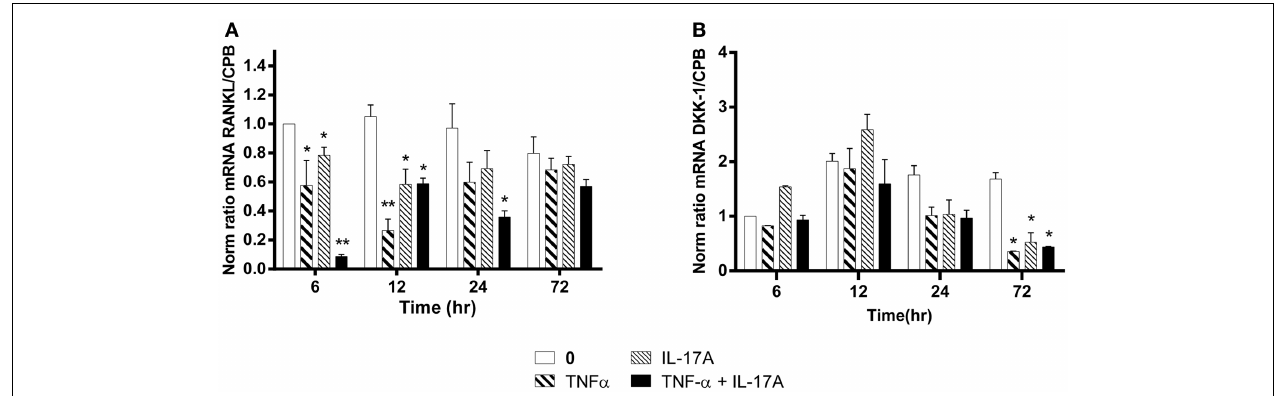
FIGURE 5 | Effects of Il-17A andTNF- α on RANKL and DKK-1 expression are shown . hMSCs were cultured in osteogenic medium in the presence or absence ofTNF- α 1ng/ml and/or IL-17A 50ng/ml. Osteogenic gene expression RANKL (A) and DKK-1 (B) were measured by qRT-PCR at early time points of 6, 12, and 24h. Results were analyzed using theWilcoxon test. * p < 0.05; ** p < 0.005 vs. induction medium alone (0), # p < 0.05TNF- α alone vs. IL-17A + TNF- α .